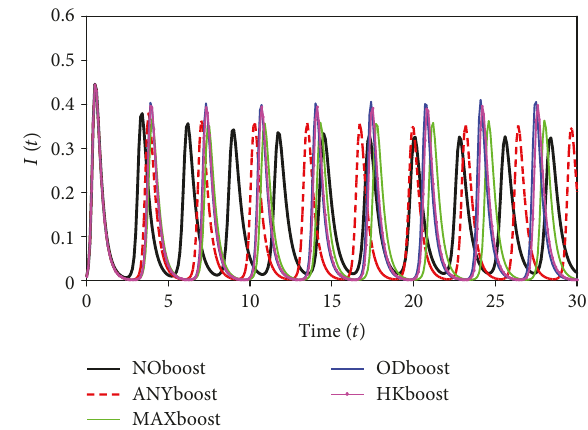
Figure 6: Infective population I t for di ff erent boosting mechanisms. Also in case of periodic oscillations, it is evident that the solution of problems governed by the boosting mechanisms ODboost and HKboost are quantitatively equivalent.